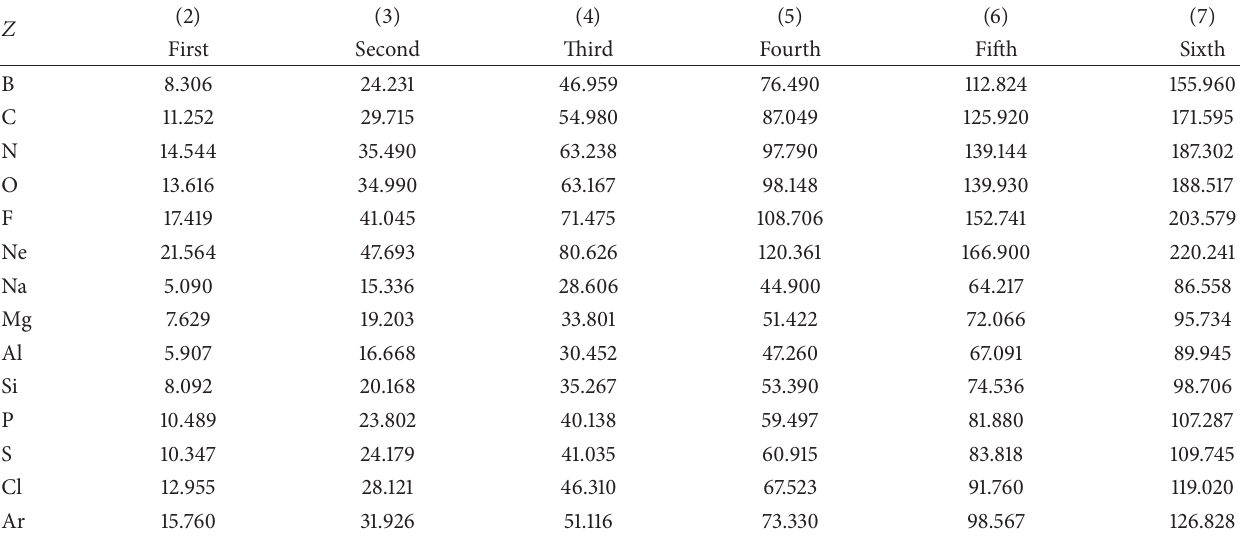
Table4:Ionizationenergies(eV)ofisoelectronicseriescalculatedusingexpression23andcoefficients/constantsfromTable 2(5to18electron